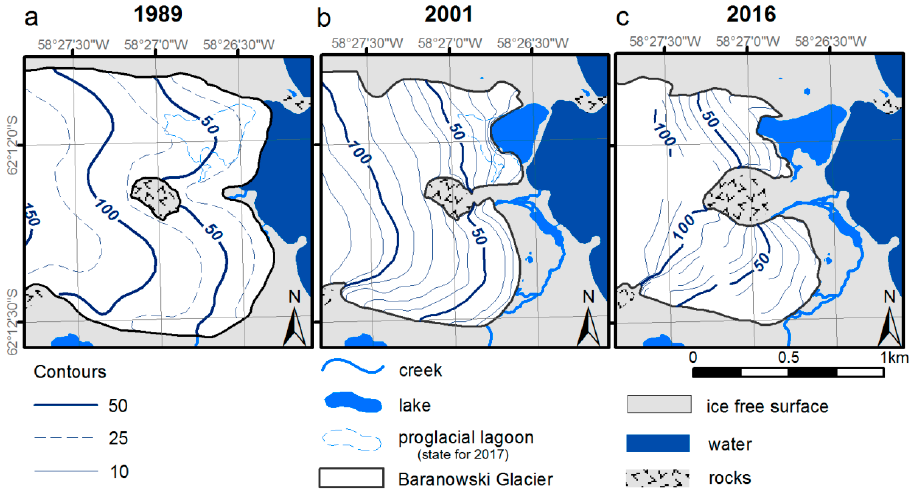
Figure 7. Ice elevation in ( a ) 1989, ( b ) 2001, and ( c ) 2016. Reference system: WGS 1984, UTM zone 21S, and geoid EGM96.